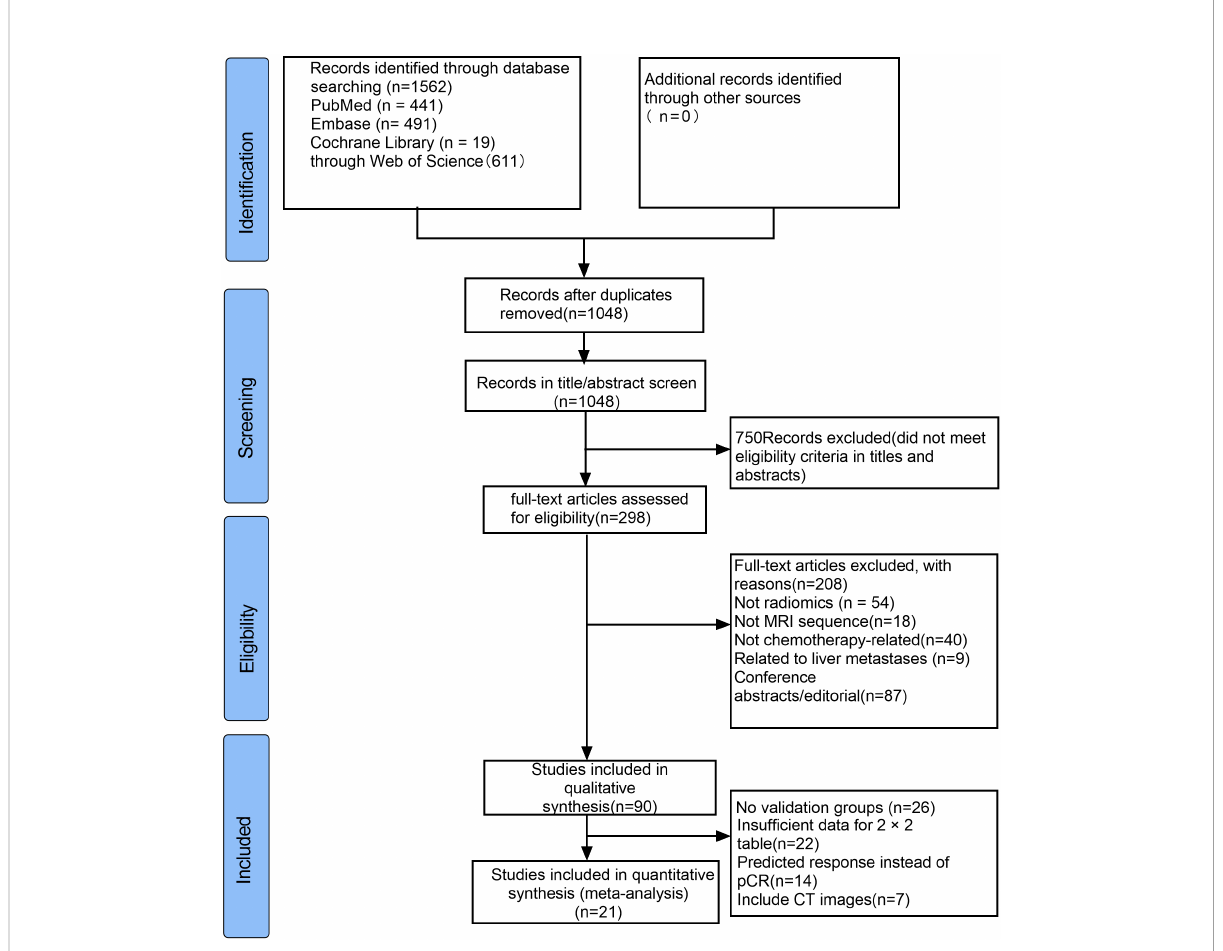
FIGURE 1 Flow diagram of the study selection process for this